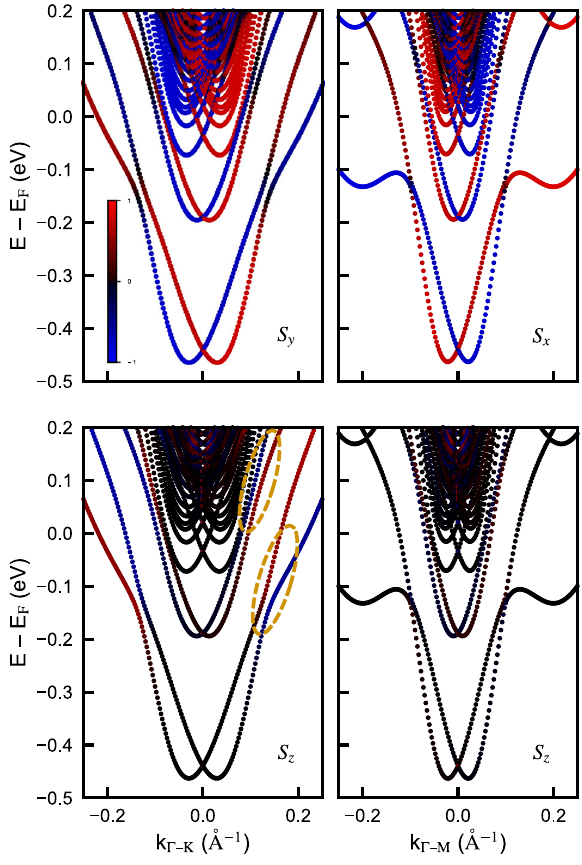
Fig. 3 BiTeCl band structure calculations. The colors denote in- plane (top row) and out-of-plane (bottom row) spin polarization for Γ -K (left column) and Γ -M (right column) directions. The orange circled regions show the reversal of out-of-plane spin texture between states localized in adjacent trilayers.